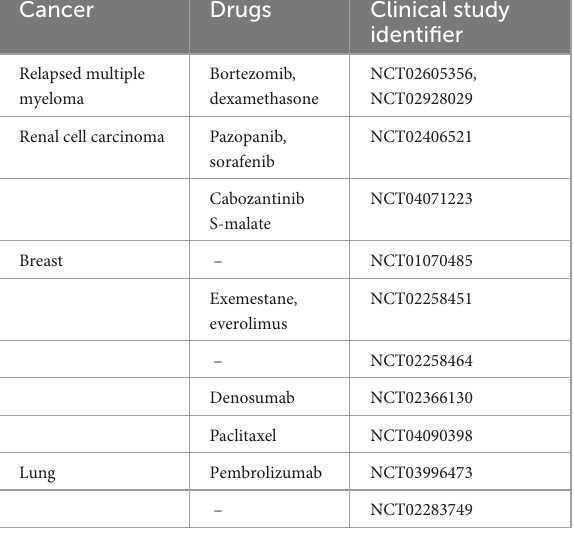
TABLE 3 List of clinical trials with Xofigo alone or in combination with other drugs in cancers with dominant osteolytic lesions. Cancer